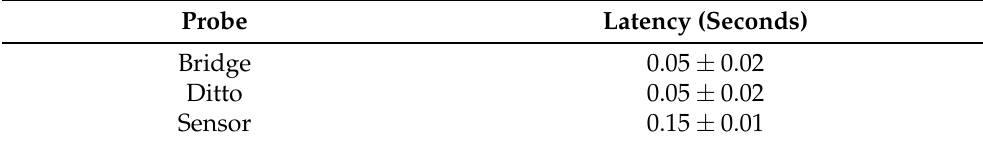
Table 7. Latency of different probes placed within the proposed platform.